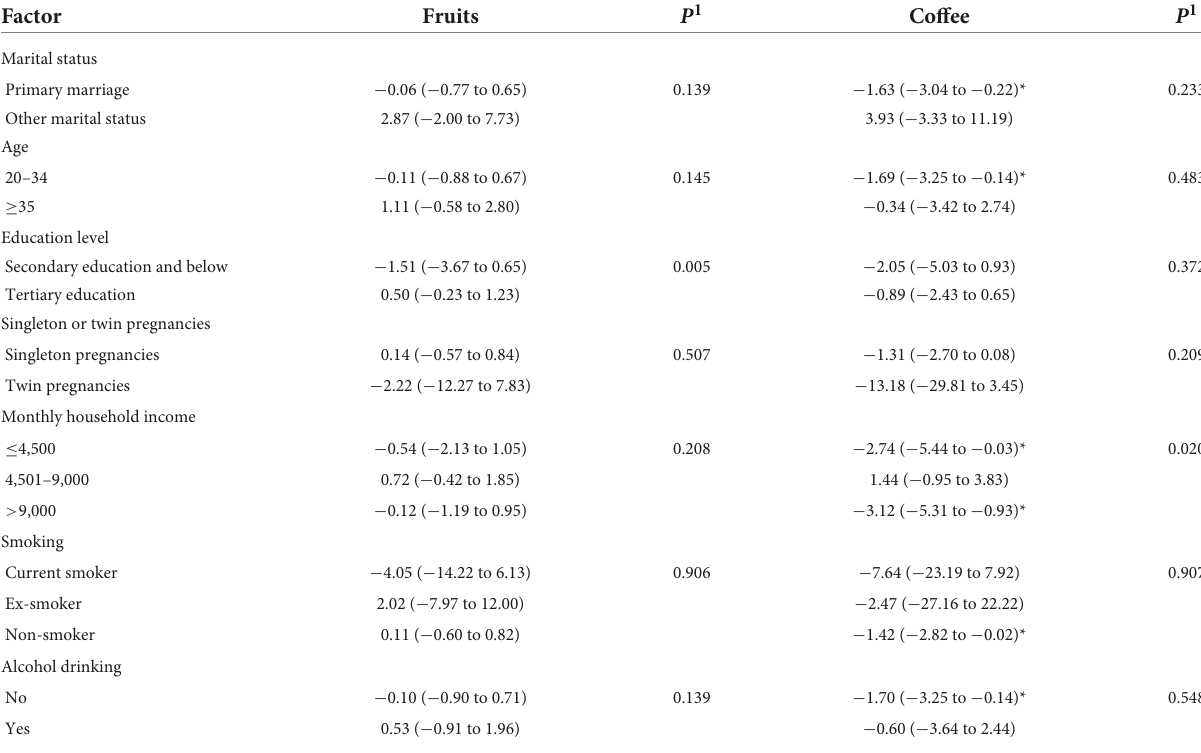
TABLE 5 Subgroup analyses of associations between modes of delivery and postpartum dietary intake in the total sample # . Factor Fruits P 1 Coffee P